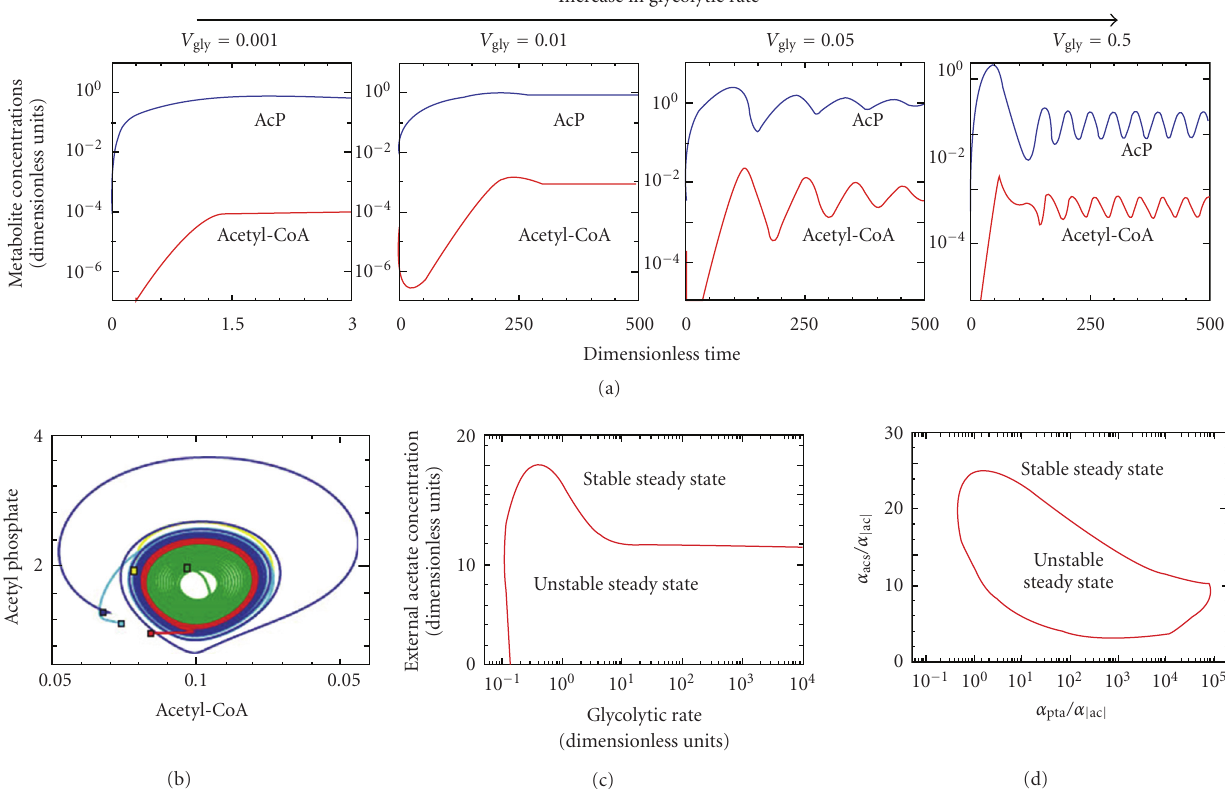
Figure 4: Sensitivity and bifurcation analyses of the metabolator model in Fung et al. [6]. (a) Sensitivity analysis: increase in glycolytic rate increases the oscillatory capability of the metabolator. The glycolytic rate V gly is equal to 0.001, 0.01, 0.05, and 0.5 in the top four panels from left to right. (b) Phase plots obtained by perturbing the steady-state solution at V gly = 1 show that the oscillatory dynamics is limit cycle oscillation irrespective of the initial condition. The initial state of the oscillator is depicted with squares. (c) Hopf bifurcation analysis was used to construct a phase diagram of glycolytic rate versus external acetate concentration. The flux-sensitive nature of the oscillations is evident here; low glycolytic fluxes lead to a stable steady state with oscillations setting in beyond a threshold value of the glycolytic flux. (d) Another phase diagram suggests that at V gly = 10, specific combinations of three protein levels are required to sustain oscillation. The variable α i represents rate of synthesis of protein i ( i : LacI, Pta or Acs) (from Fung et al. [6], with